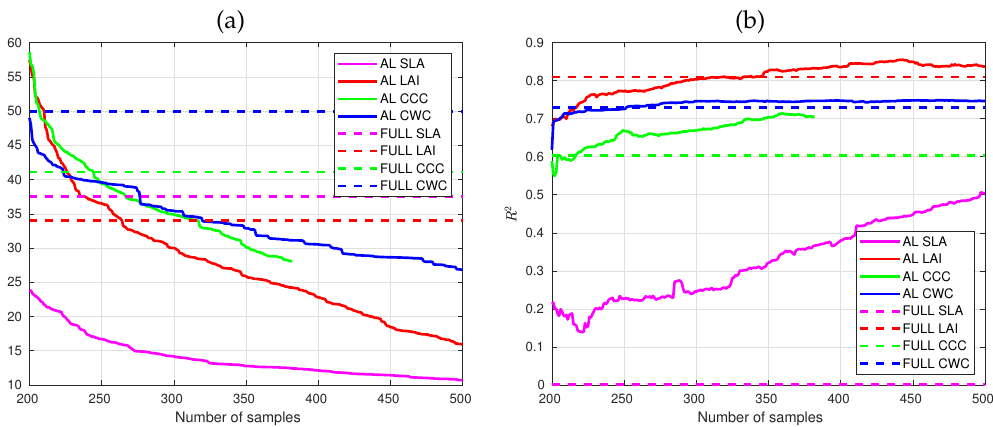
Figure 3. ( a ) NRMSE obtained when applying the EBD procedure to optimize sampling data for estimation of all variables and ( b ) resulting R 2 of the EBD procedure (AL: optimization with AL, FULL: all